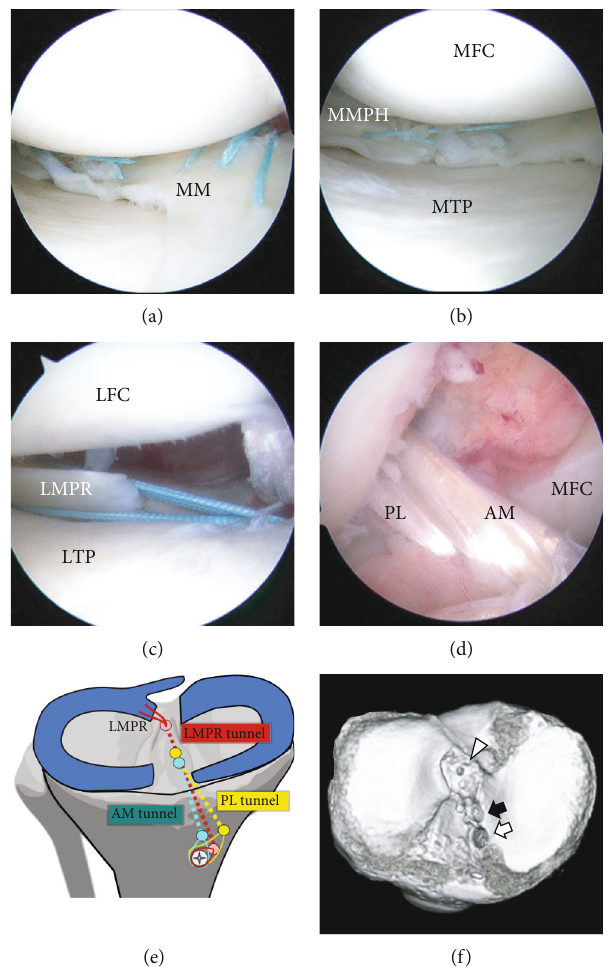
Figure 2: (a – d) Arthroscopic fi ndings and illustrations of the tunnel positions and postoperative three-dimensional computed tomography. (a) Repaired bucket handle tear of the MM. (b) Repaired radial tear of the posterior horn of the MM. (c) A 6 mm gap between the edge of the repaired LMPR and the bone aperture site remained. (d) Reconstructed ACL. (e) Illustration of the tunnel locations for the pullout repair of the LMPRT and the reconstruction of the AM bundle and the PL bundle. (f) The tibial tunnel for the LMPRT (arrowhead) was placed separately with a tunnel for the PL bundle (black arrow) and the AM bundle (white